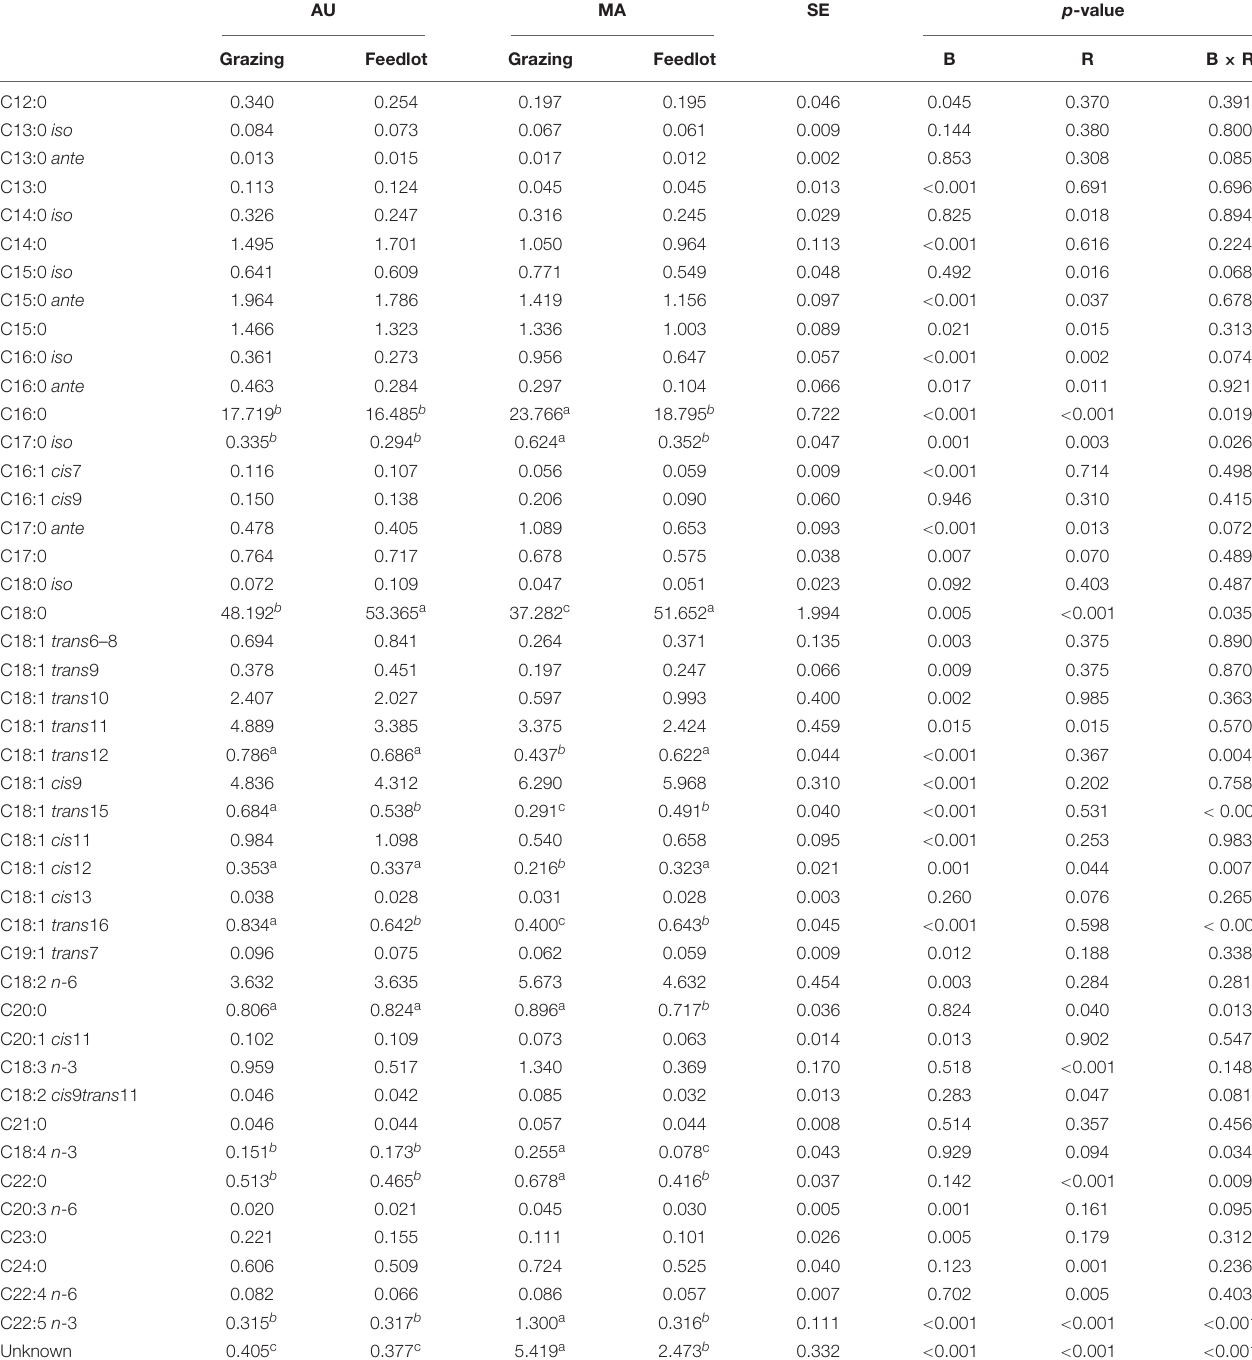
TABLE 2 | Relative percentage of selected fatty acids (g/100 g of total FAs) in the rumen liquor from Aubrac or Maremmana steers maintained in feedlot or on pasture. AU MA SE p -value Grazing Feedlot Grazing Feedlot B R B ×